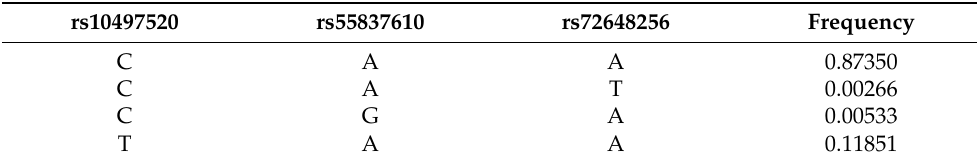
Table 7. Frequency of haplotypes.